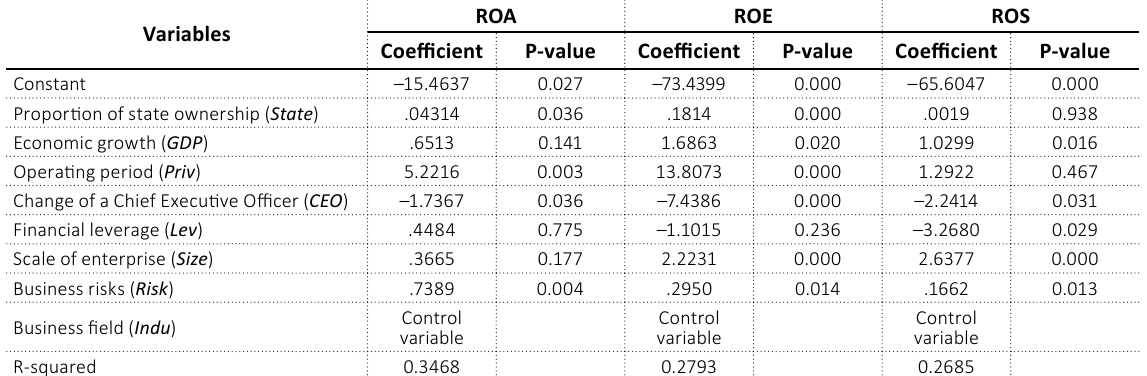
Table 6. Result summary for the linear regression estimation of models ROA, ROS,